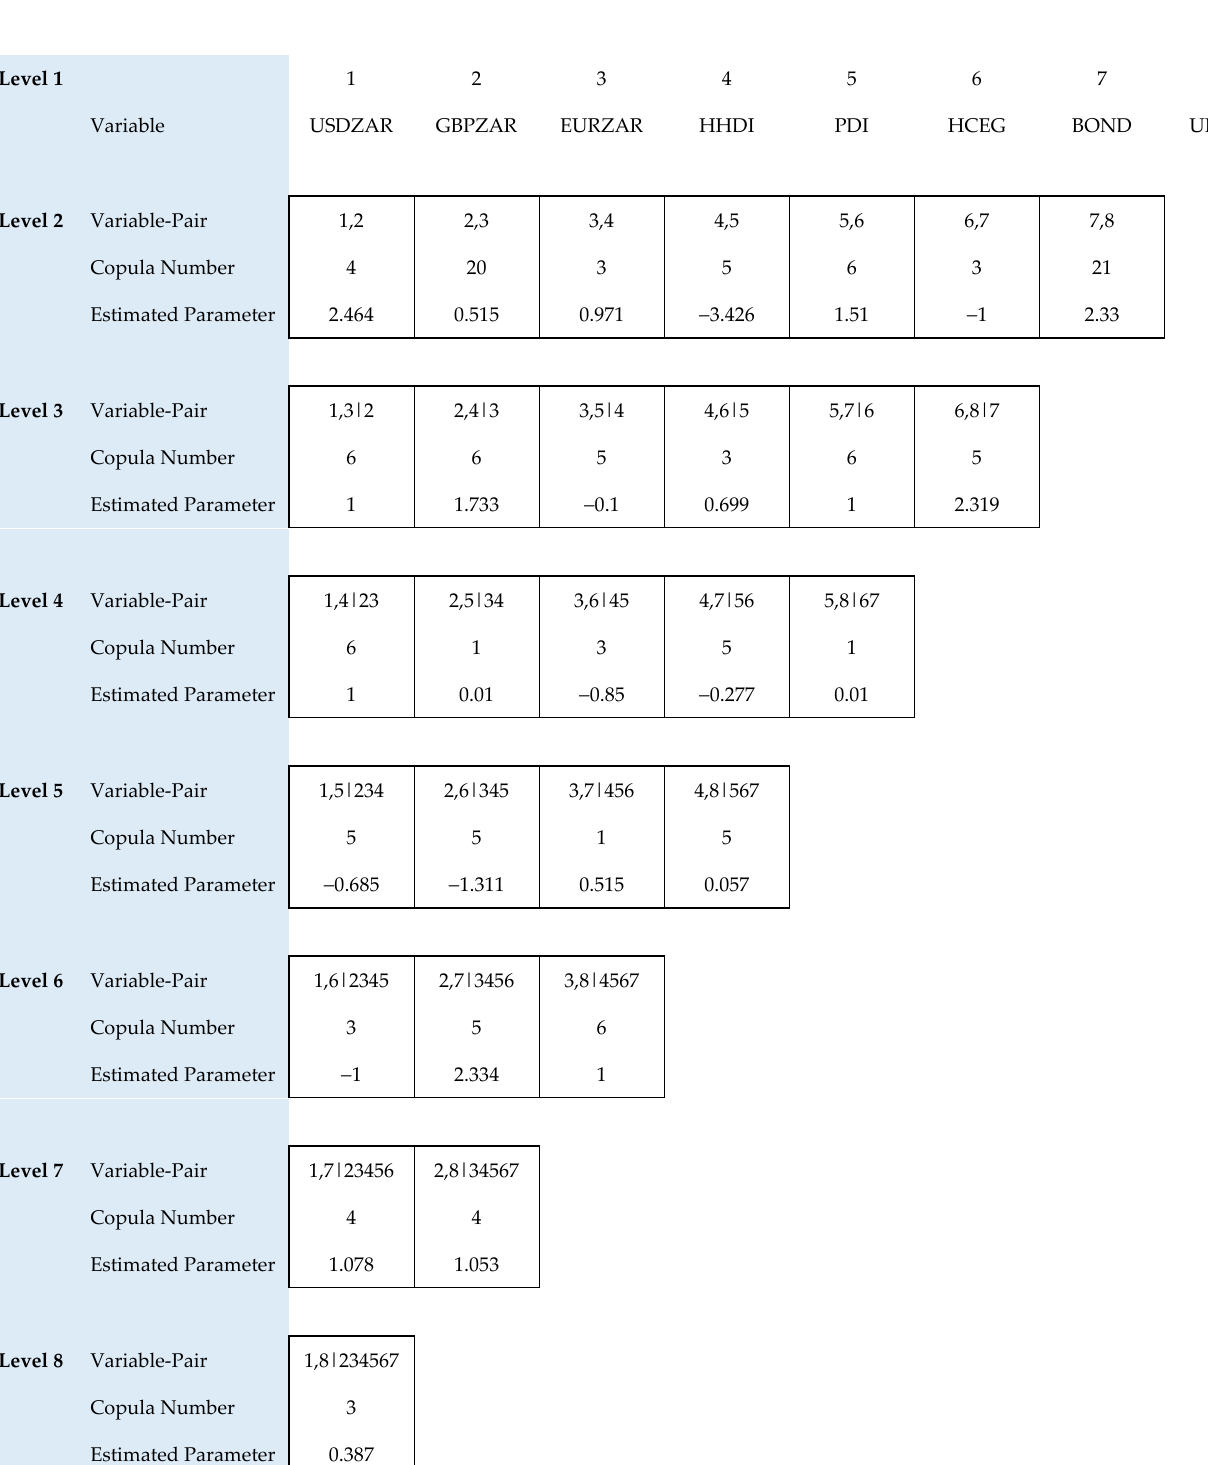
Figure 3. D-vine copula fitted to the economic variables {USDZAR, GBPZAR, EURZAR, HHDI, PDI, HCEG, BOND, UNEMP} with quarterly data from 2010 to 2018.